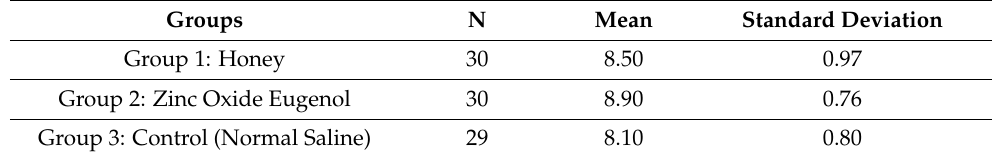
Table 2. Premedication VAS score of participants of all